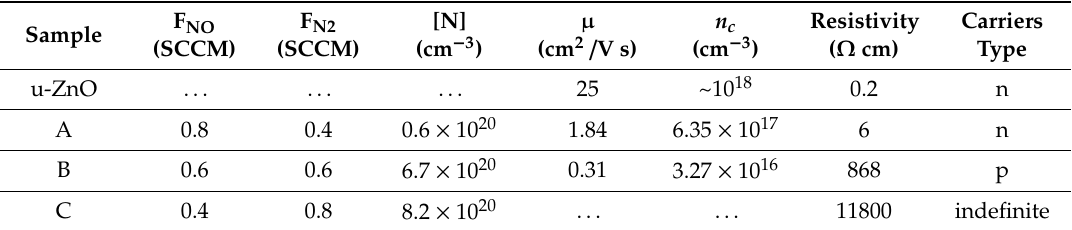
Table 1. Electrical properties and nitrogen concentration of undoped ZnO and ZnO:N films with di ff erent NO and N 2 flux.